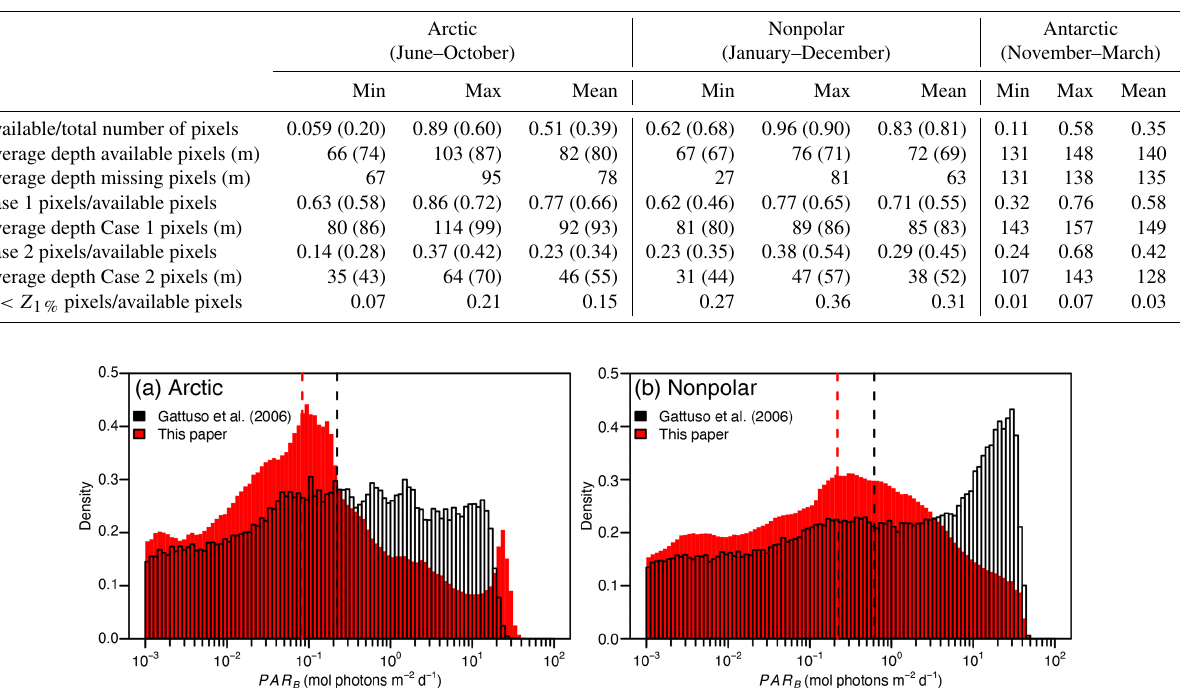
Figure 2. Distribution of PAR B in the Arctic (a) and nonpolar (b) regions in the present study and in Gattuso et al. (2006). The dashed vertical lines represent the median values in Gattuso et al. (2006) (black) and the present (red)